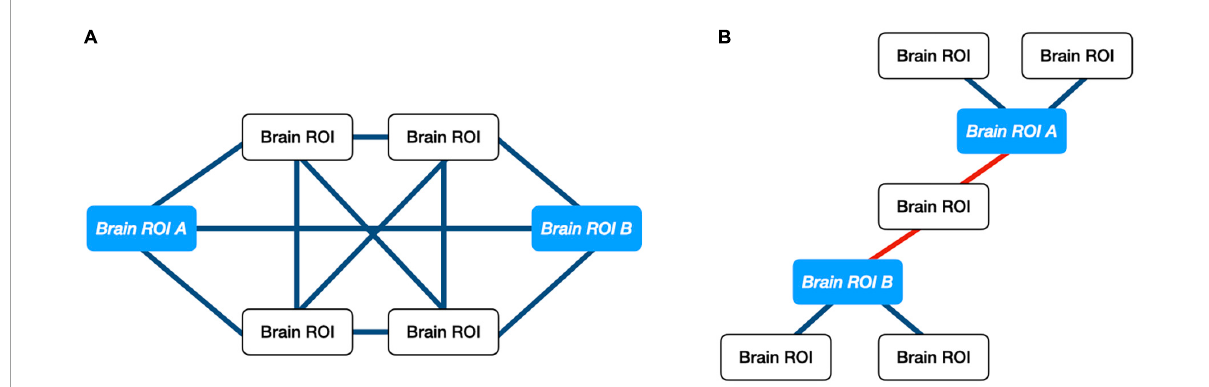
FIGURE1 Illustration of ORC on exemplar networks. (A) Example of positive ORC. Multiple pathways between two brain regions implies that information between those regions may withstand small perturbations. (B) Example of negative ORC. A single pathway between two brain regions implies that information shared between “ROI A” and “ROI B” can be altered easily. Only a single connection would need to be